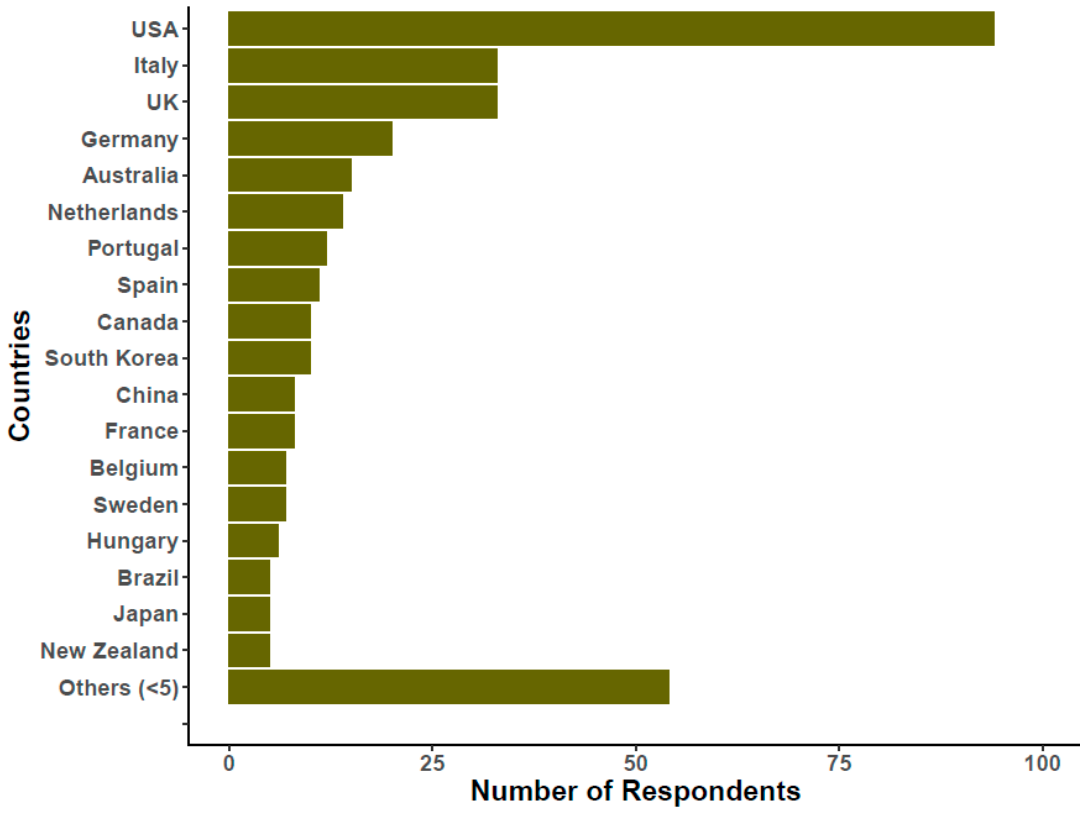
Figure 1. Number of respondents classified by the nationality of their institutional affiliation. The graph was generated from 357 responses.